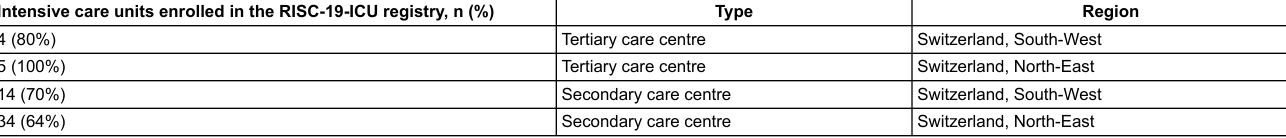
Table S1: Intensive care units enrolled in the RISC-19-ICU registry in Switzerland with the centres’ role and region. Intensive care units enrolled in the RISC-19-ICU registry, n (%)